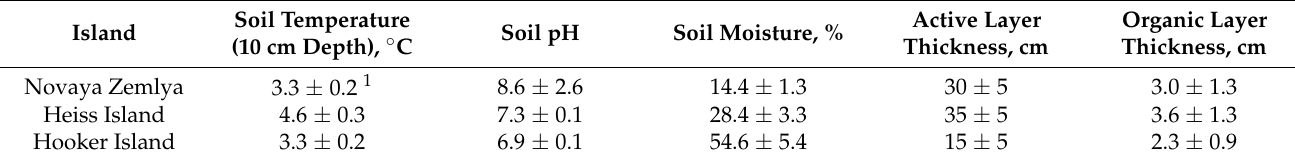
Table 1. Soil properties of the study